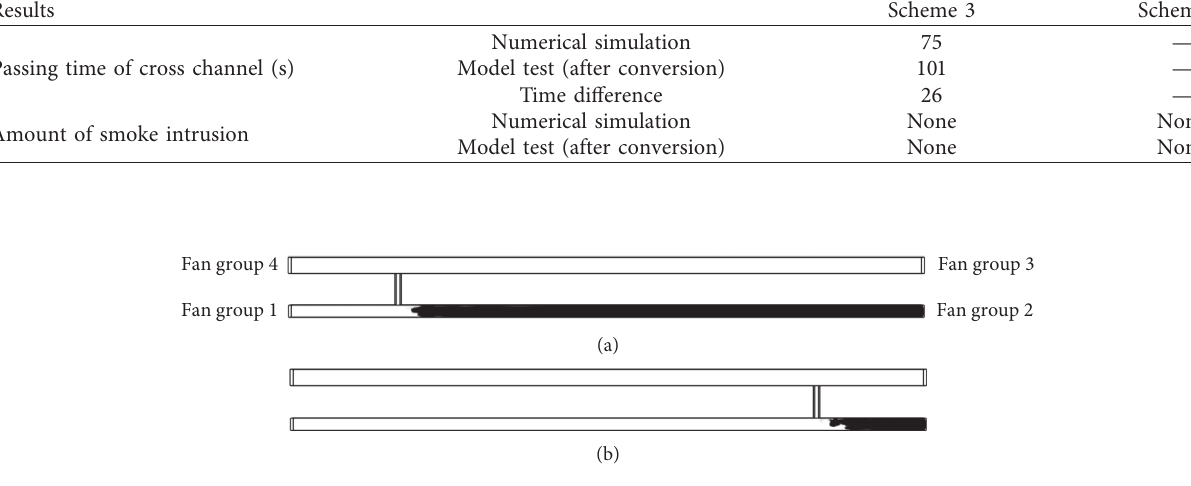
Figure 12: (a) Smoke diffusion at 300s when the fire is near the entrance of the fire tunnel. (b) Smoke diffusion at 300s when the fire is near the exit of the fire